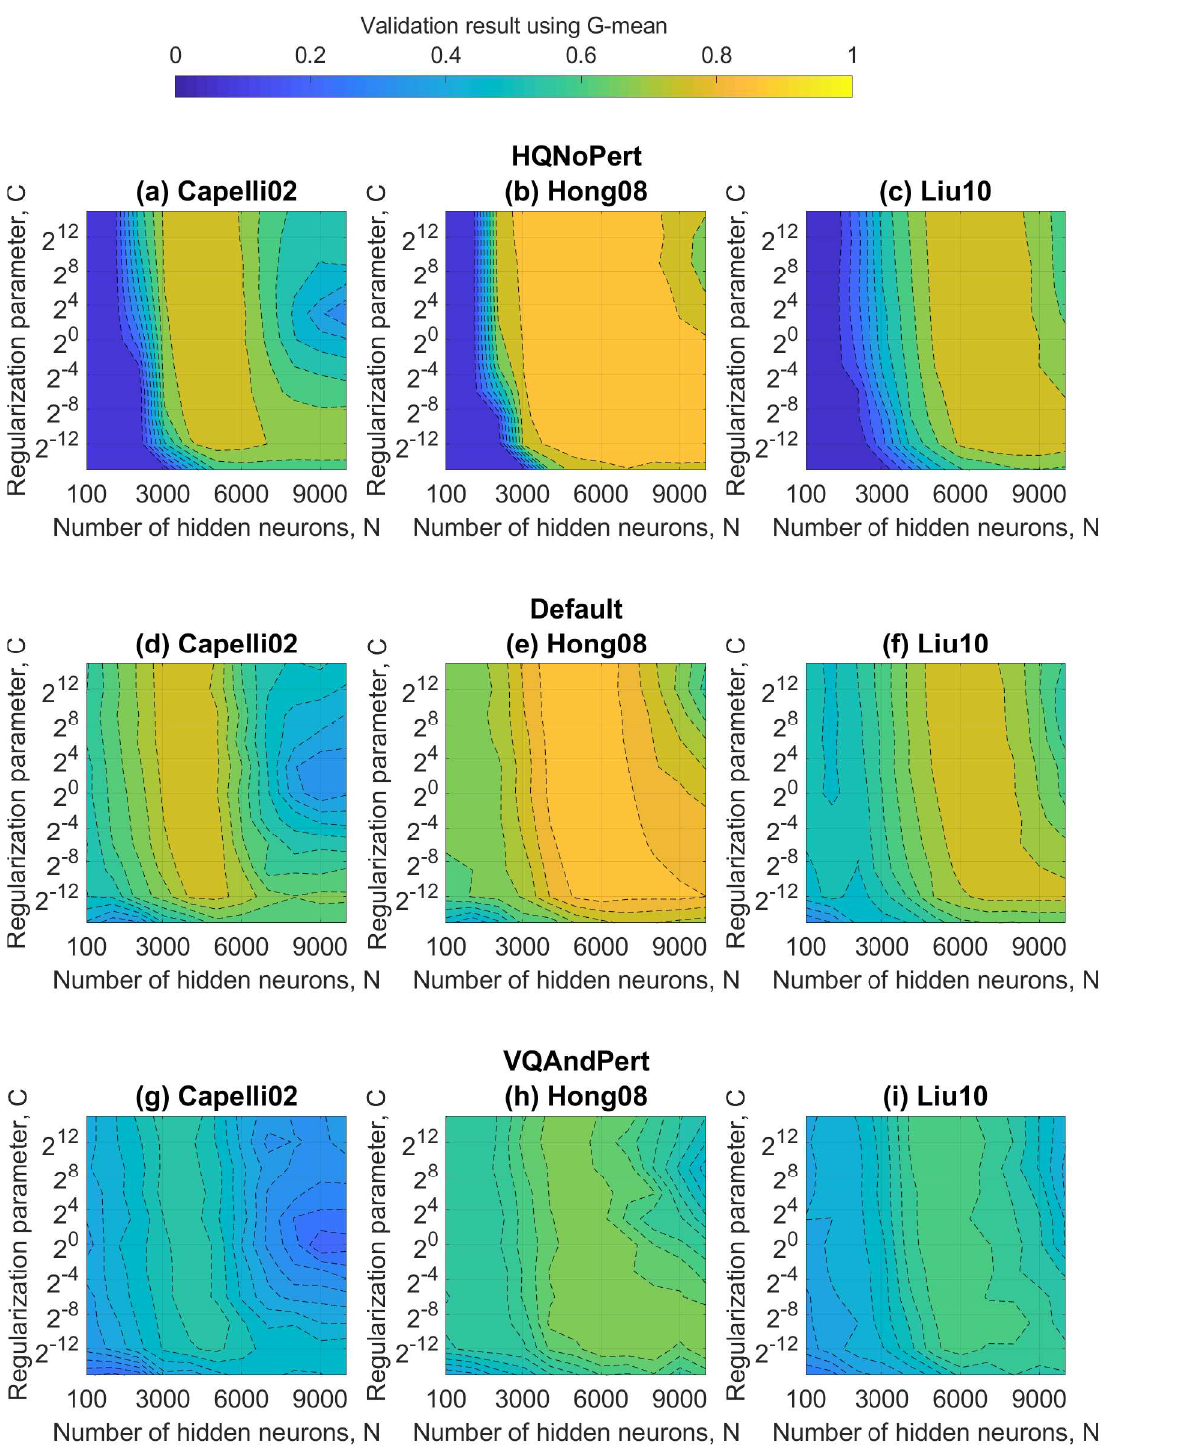
Figure 7. Validation results obtained by the weighted ELM (W-ELM1) as a function of the regularization parameter and number of hidden neurons. Each subfigure illustrates the database and feature